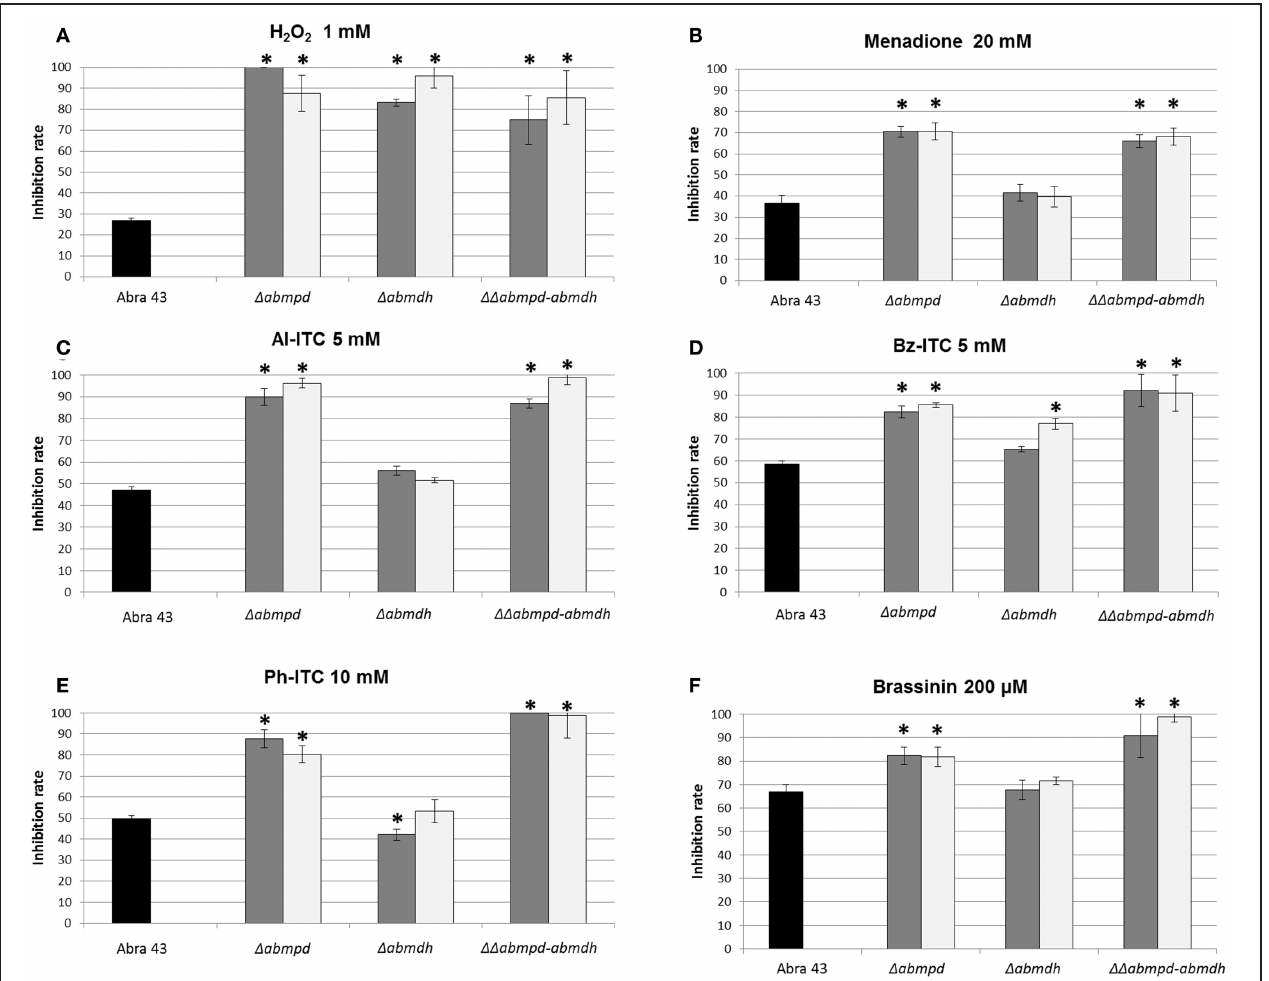
FIGURE 5 | Growth inhibition rates of the wild-type strain (black bars) and mannitol metabolism deficient mutants (2 transformants by genotype, gray, and white bars) in the presence of several molecules: H 2 O 2 (1mM) (A), menadione (20mM) (B), Al-ITC (5mM) (C), Bz-ITC (5mM) (D), Ph-ITC 10mM (E) and brassinin (200 µ M) (F). The results are expressed as the percentage of inhibition in treated samples compared to the control without additive. Conidia were used to inoculate microplate wells containing standard